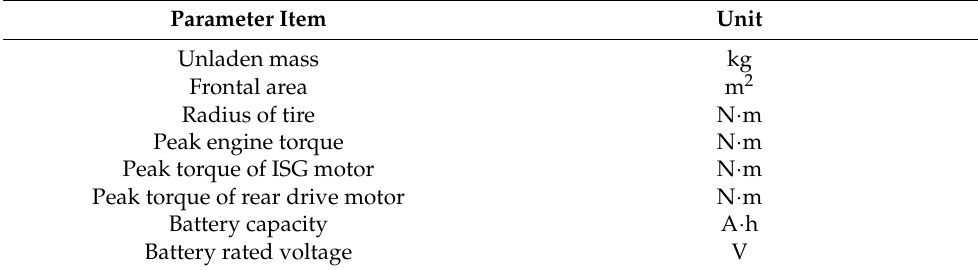
Table 3. Performance parameters of main components of the whole